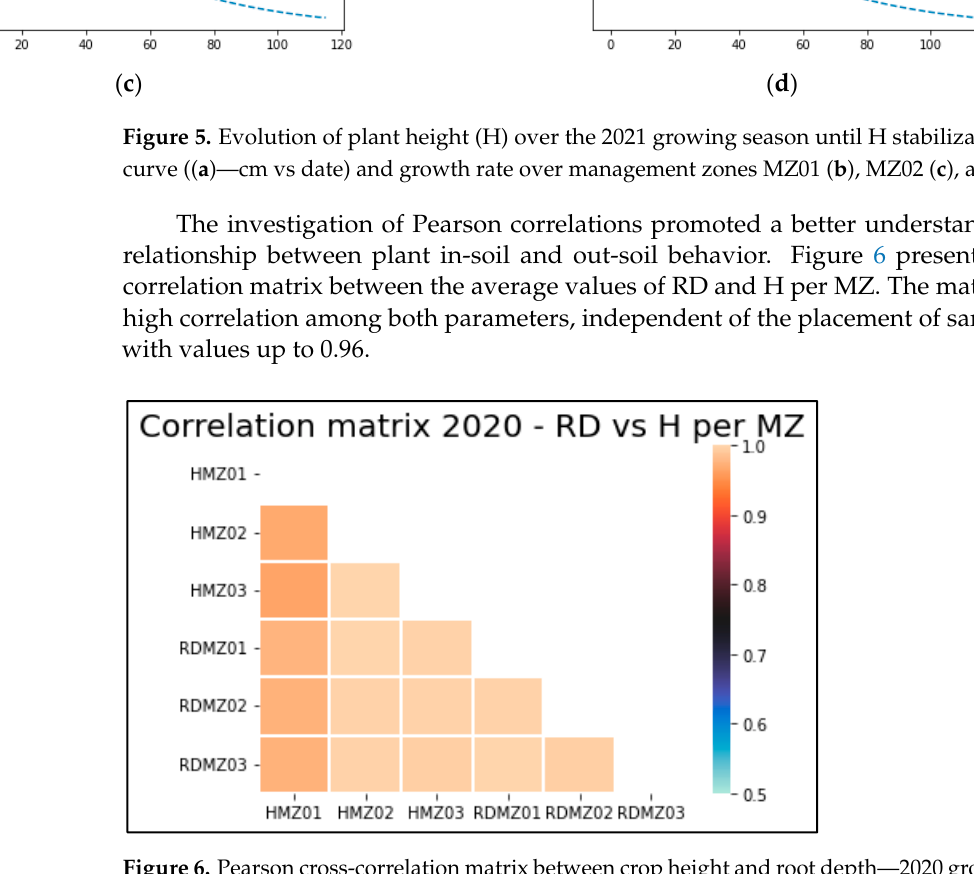
Figure 6. Pearson cross-correlation matrix between crop height and root depth—2020 growing sea- son.